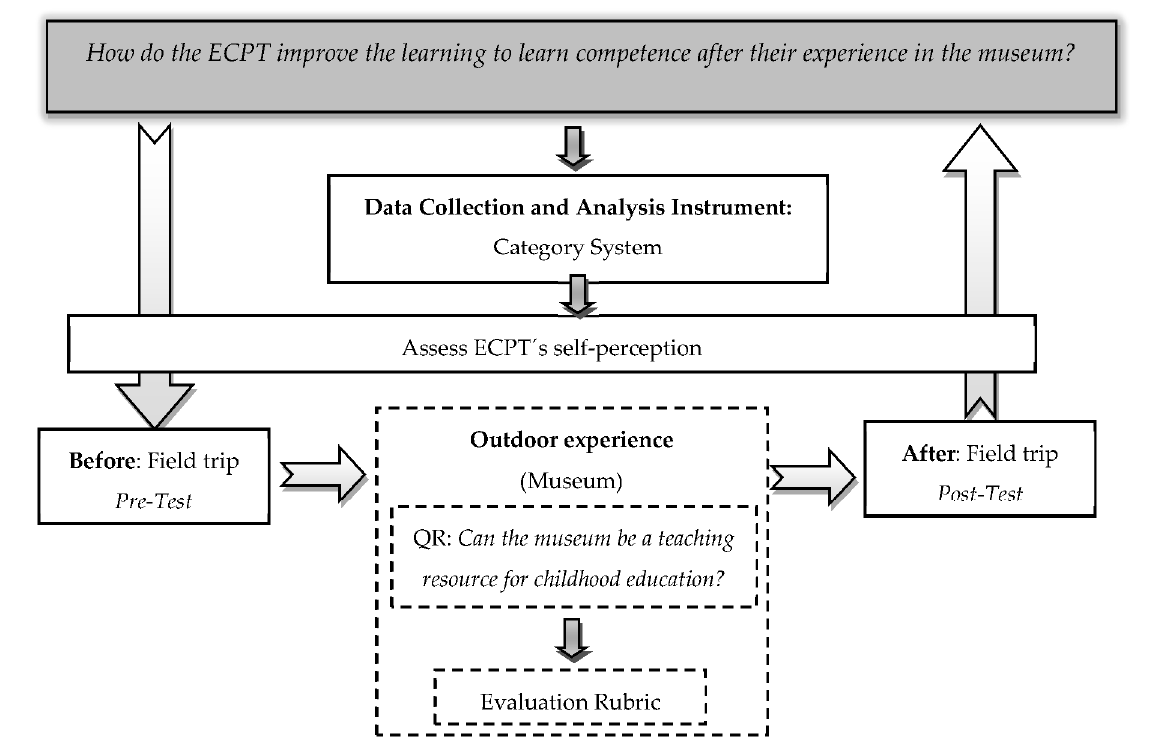
Figure 1. Outline of the investigation.